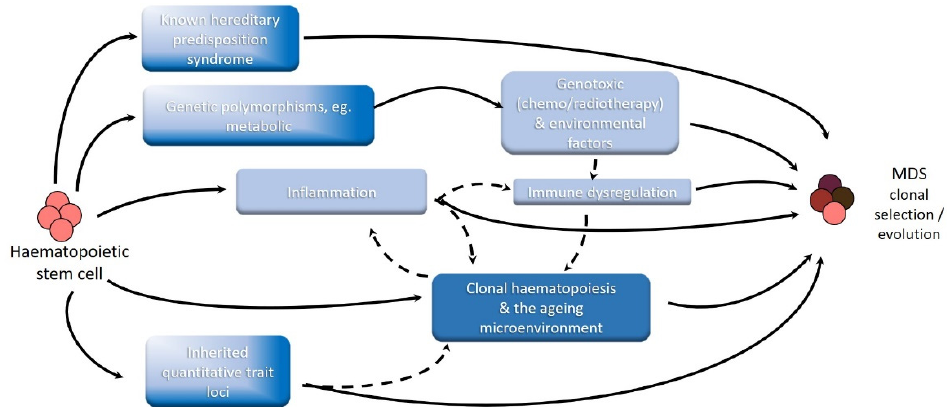
Figure 1. Etiological and pathological processes leading to MDS. Graded blue fill—inherited factors. Light blue and dark blue fill—pathological mechanisms Demographics